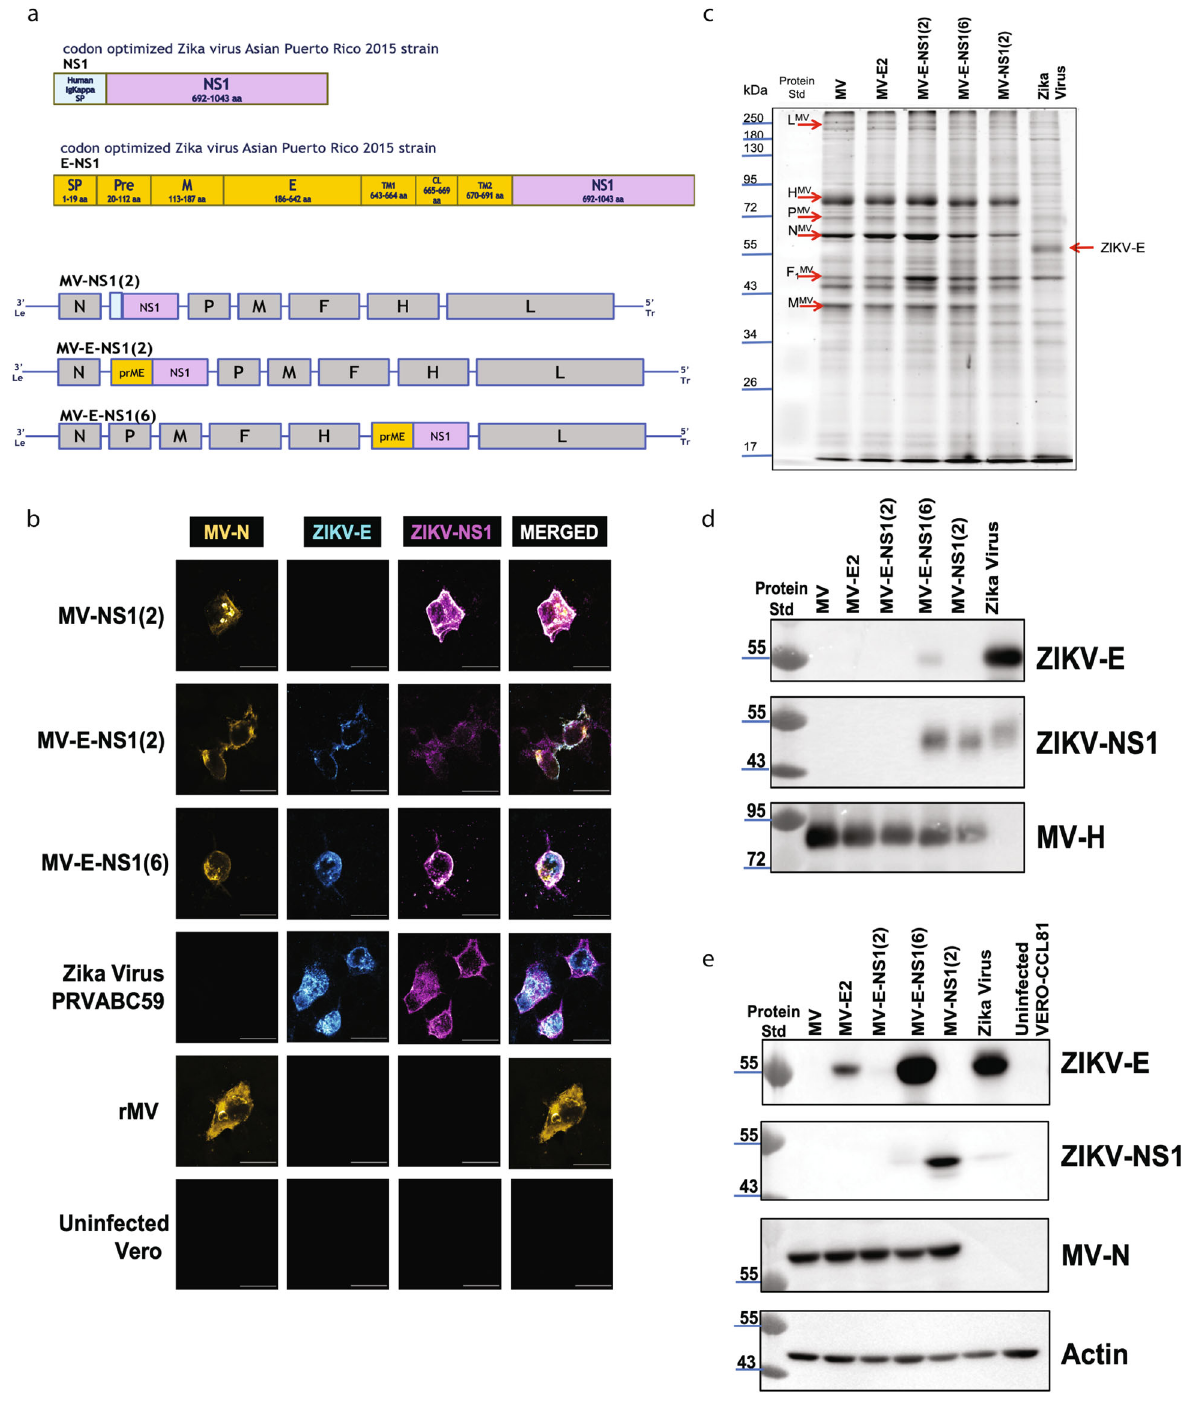
Fig. 3 Generation and characterization of second-generation MV-based candidate ZIKV vaccines. a Second-generation vaccine constructs. b Immuno fl uorescence staining of Vero cells were infected at MOI-0.1 for 72 h with the recovered modi fi ed MV-ZIKV candidate vaccines and control viruses. The permeabilized cells were stained for MV using an α -MV N protein (Sigma, NP-Cl25) mouse monoclonal conjugated with dylight488 (green color changed to Yellow for visualization), for the ZIKV-E using a mouse monoclonal antibody (Biofront-1176-56) and for ZIKV NS1 using human monoclonal antibody EB9. ZIKV-E is stained with a secondary α -mouse AF568 (red color changed to Cyan for visualization) antibody and ZIKV-NS1 is stained with a secondary goat α -human AF-647 (far-red color changed to Magenta for visualization) antibody. Confocal images were taken using NIKON-A1R, 60X magni fi cation, 2.5X zoom. The scale bar measures 30 μ m. The data is representing one replicate of n = 3. c Sucrose-puri fi ed virions were analyzed on SDS-PAGE (10%) stained with SYPRO Ruby. Zika virus PRVABC59 was loaded with the control virus. The data is representing one replicate of n = 3. d Western blot analysis of sucrose puri fi ed virions probed for ZIKV-E (Biofront mouse mAb-1176) and MV-H (Rabbit polyclonal sera). Zika virus PRVABC59 was loaded as the control virus. The data is representing one replicate of n = 3. e Western blot analysis of cell lysates of Vero cells infected with MV-ZIKV candidate vaccine at MOI- 5. Zika virus PRVABC59 infected cell lysates were loaded as the control. The blot was probed for ZIKV-E (Biofront mouse mAb), ZIKV-NS1 (Abcam, B4 mouse mAb) and MV-N (Sigma, NP-Cl25). The data is representing one replicate of n =